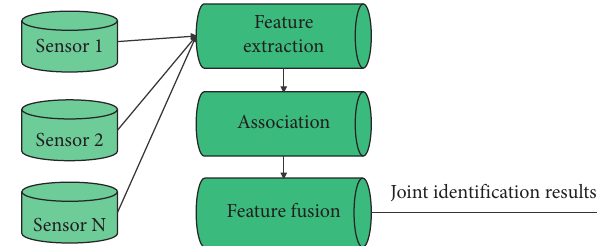
Figure 2: Block diagram of target characteristic information